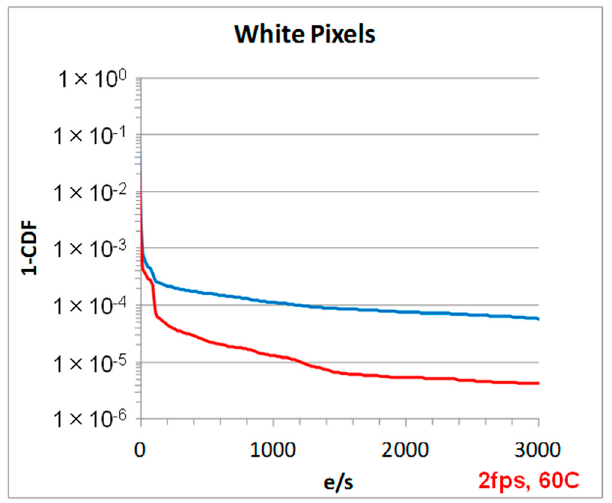
Figure 9. Plot of 1-cumulative density function (1-CDF) comparing the dark image from low white-pixel, PD process. 1 µm, 16 MP (2 fps, 60 C).